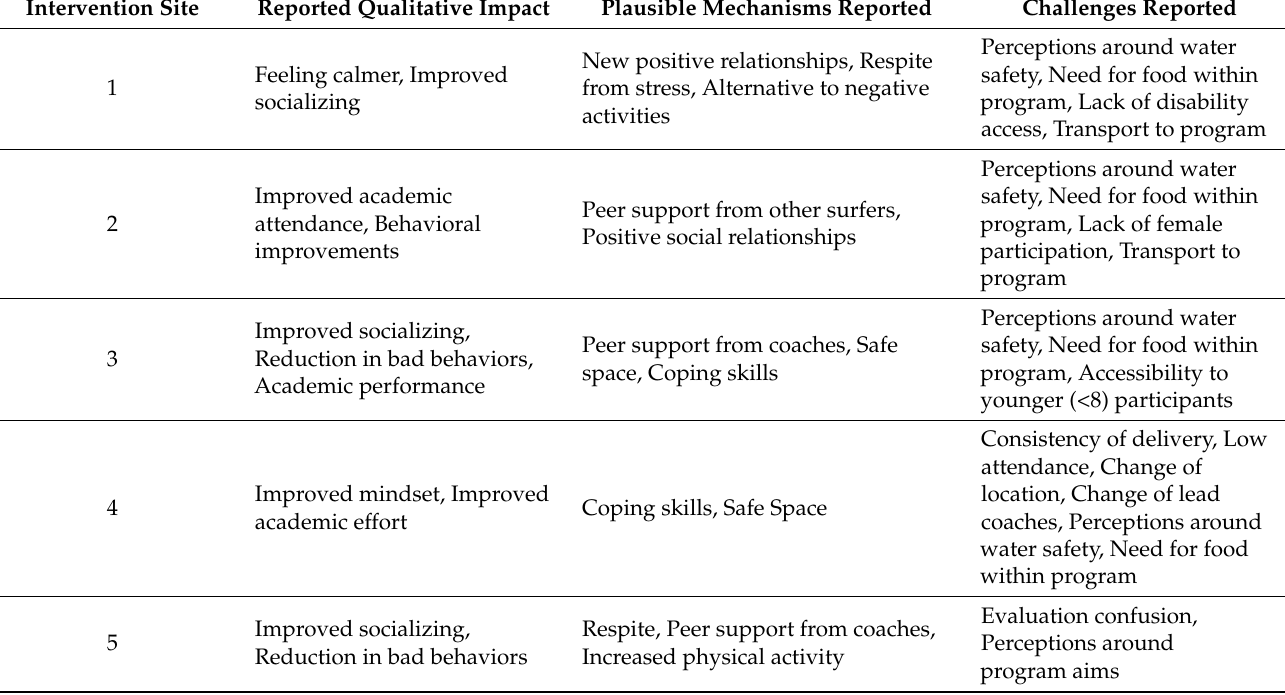
Table 3. Summary of qualitative reporting within surf therapy